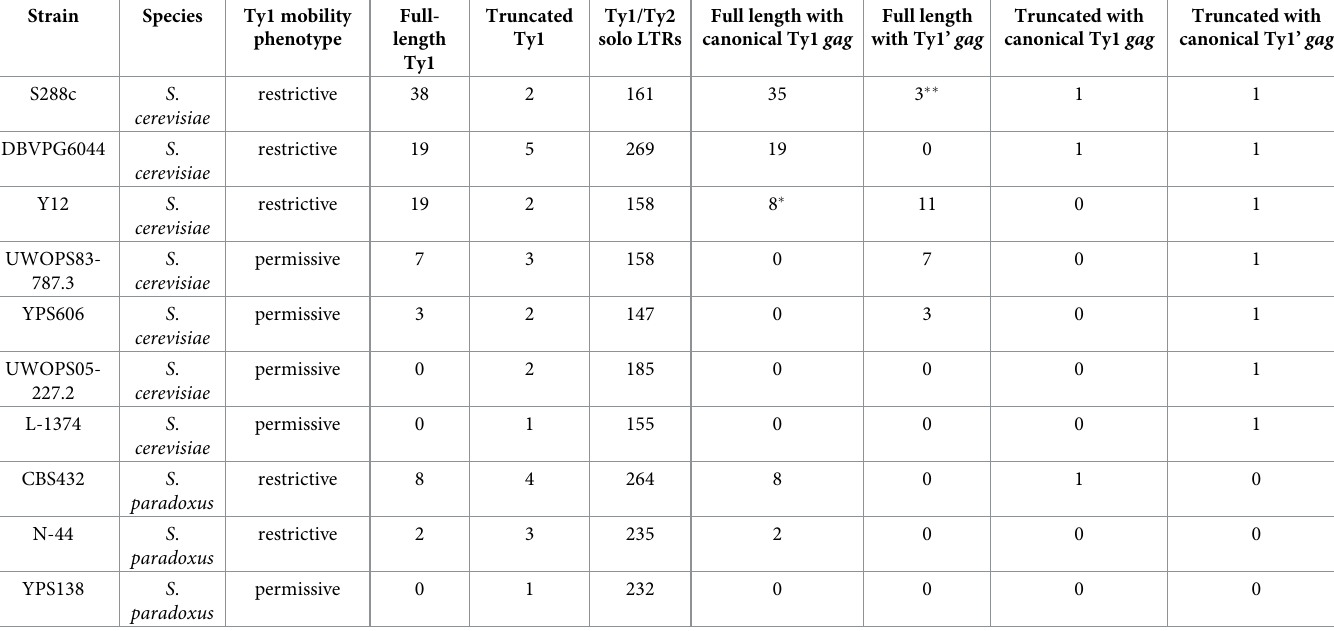
Table 3. Ty1 content in a diverse panel of S . cerevisiae and S . paradoxus strains with Ty1 mobility phenotypes.